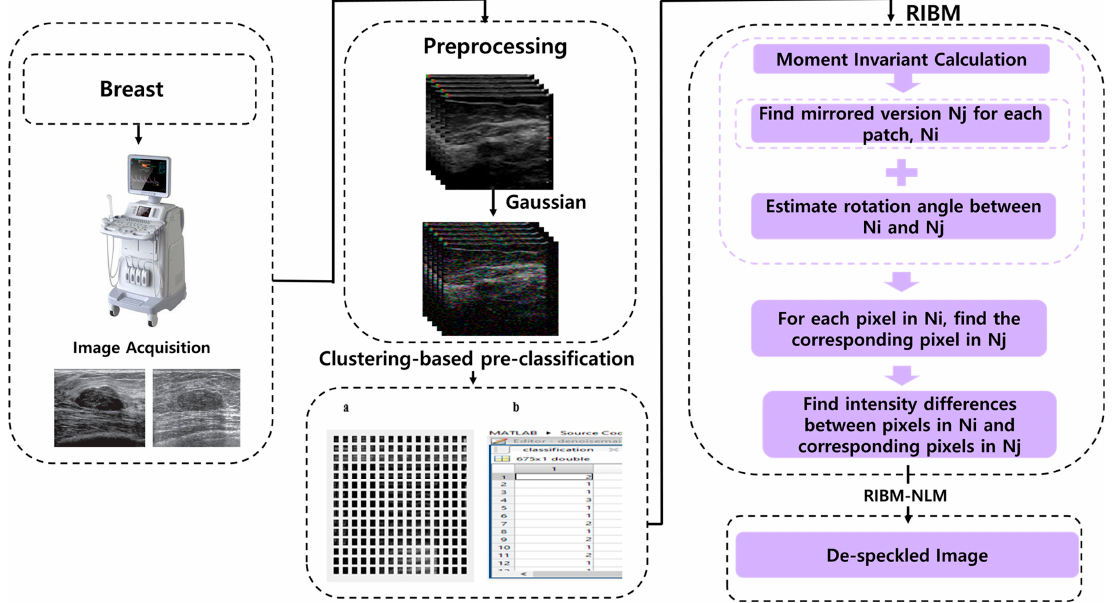
Figure 1. Processing pipeline of the RIBM-NLM method. ( a ) Patch separation; ( b ) K-means clustering. 𝑁 (cid:3036) , 𝑁 (cid:3037) denote two different patches of fixed size whose central pixels are 𝑖 , 𝑗 , respectively.